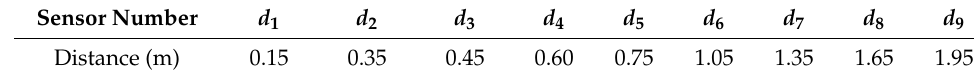
Table 4. The distance from sensor to coordinate origin.